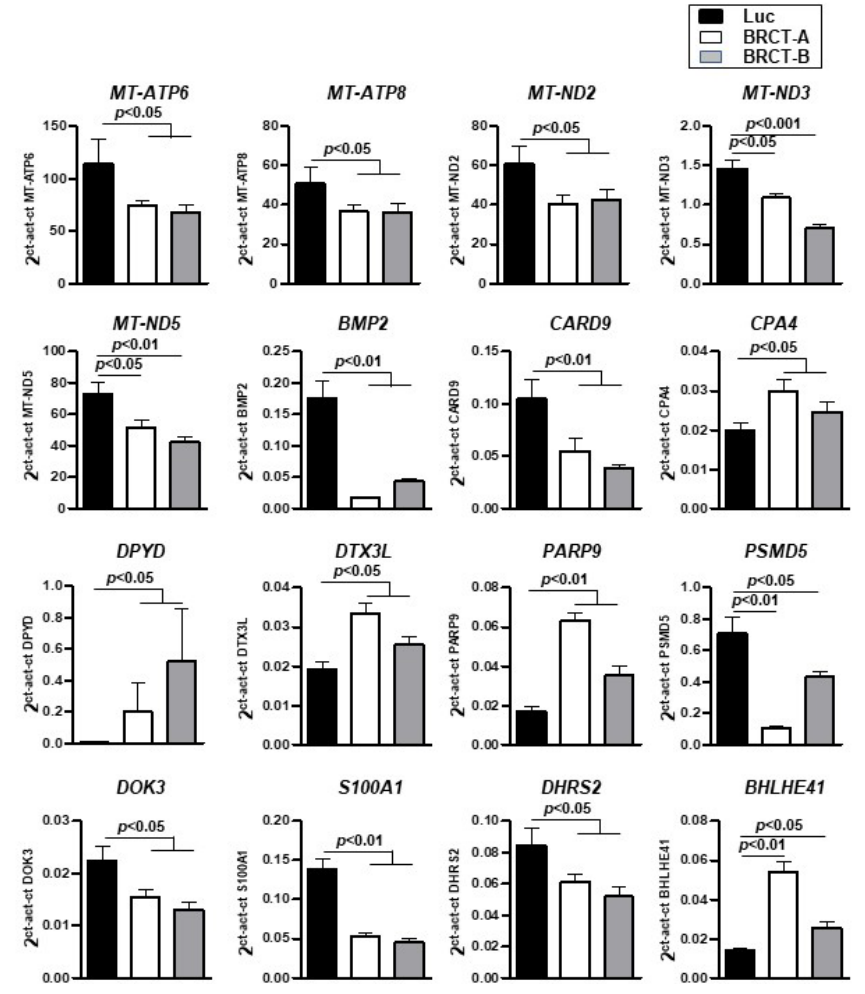
Figure 8. Validation of gene expression by real time-PCR. mRNA expression levels of 16 dysregulated genes found in the RNA-seq analysis and validated by real time-PCR, in HEK293T cells infected with lentiLuc (Luc) or lentiBRCT (BRCT-A and BRCT-B). The values shown in the figure represent the mean ±SD of sextuplicates.